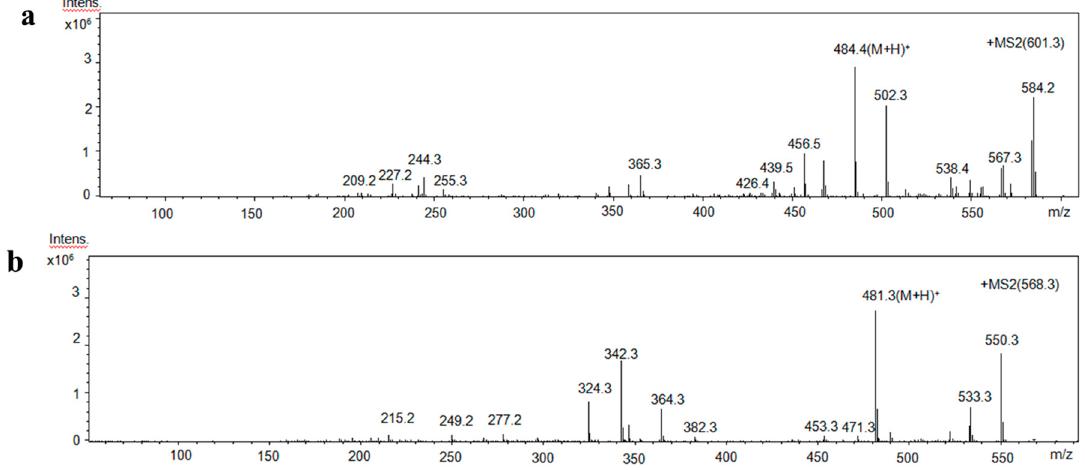
Figure 7. MS/MS spectra of ( a ) ion ( m / z 601.3) from IV-B1-d; and ( b ) ion ( m / z 568.3) from